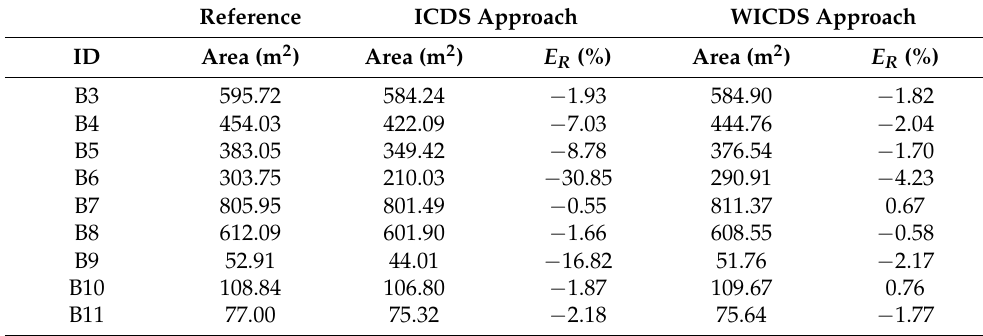
Table 1. Estimated area and relative error in area using ICDS and WICDS approaches.